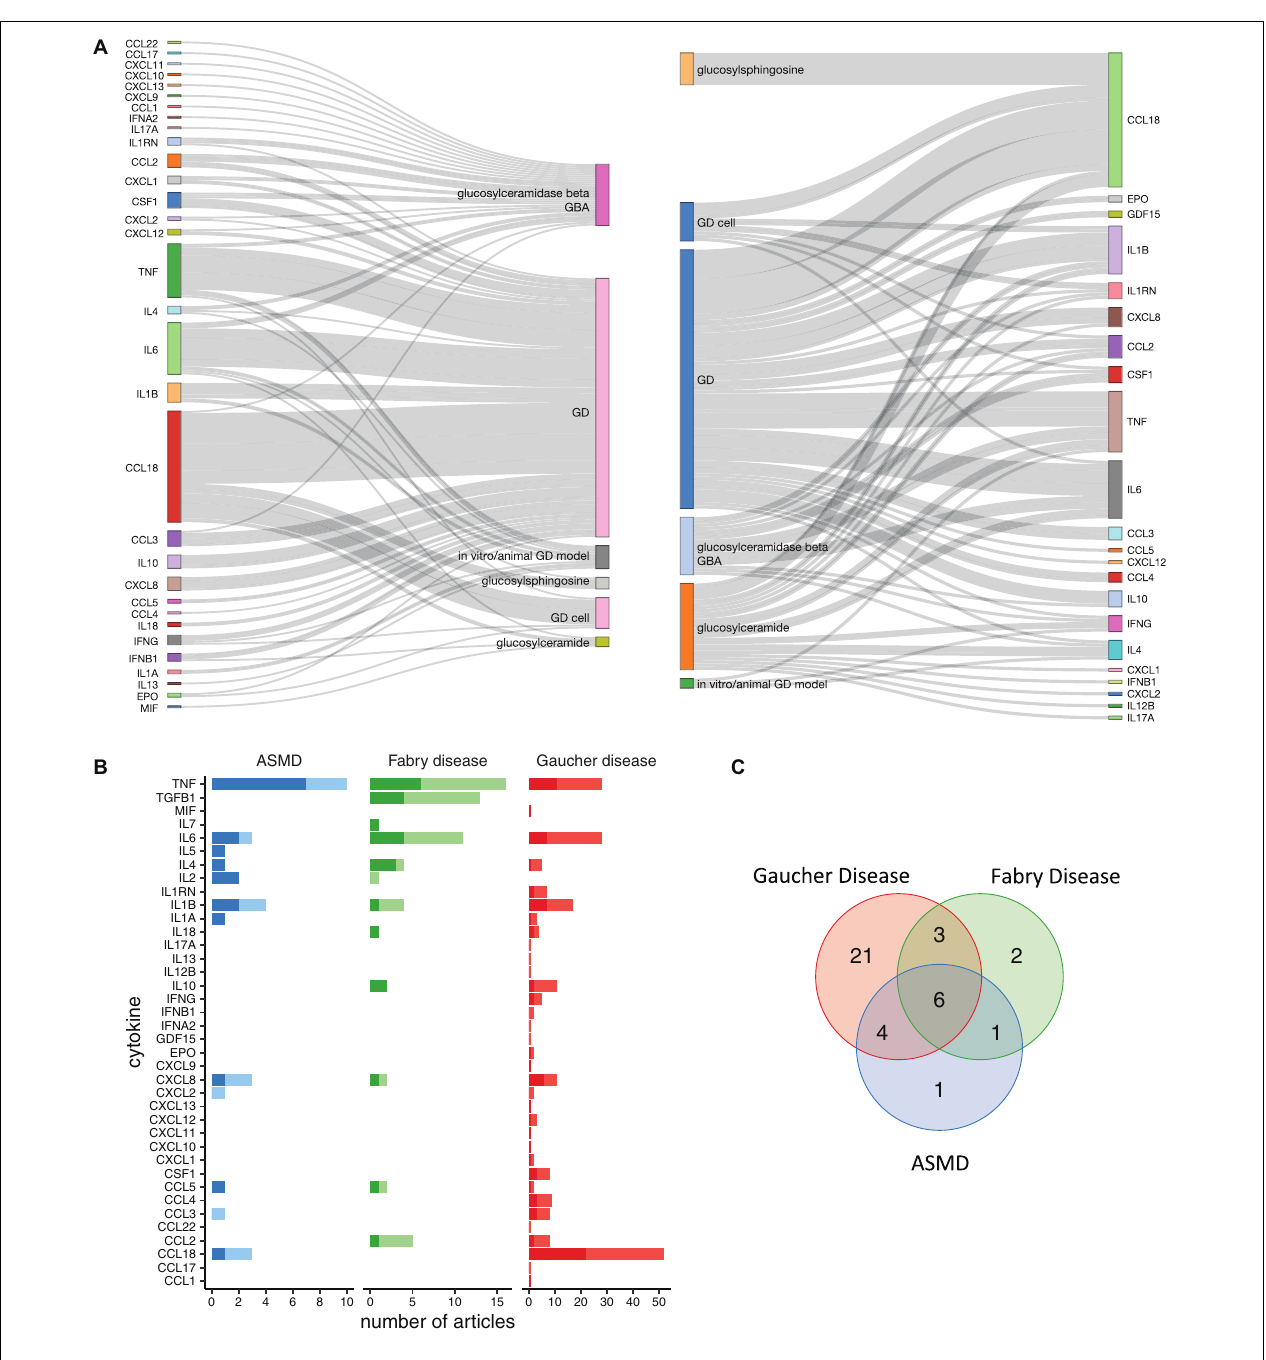
FIGURE 2 | Cytokines identified by the text-mining pipeline. (A) Linguistic structure of the mined text, shown as a bi-partite information flow, in the GD literature. The chart summarizes the directional associations between cytokines and the disease-related terms. The relations derived from sentences in which the cytokine is the subject are shown on the left, instead those in which the cytokine is more of an object are shown on the right. (B) The chart shows the number of papers mentioning each cytokine in association with the disease. Darker colors indicate that at least one sentence mentioning cytokine-disease association is present in the title or abstract of the article, suggesting that the identified association is probably a key finding. Lighter colors indicate the cytokine-disease associations derived from other sections of the article. (C) Venn diagram of the lists of cytokines obtained for the three diseases.